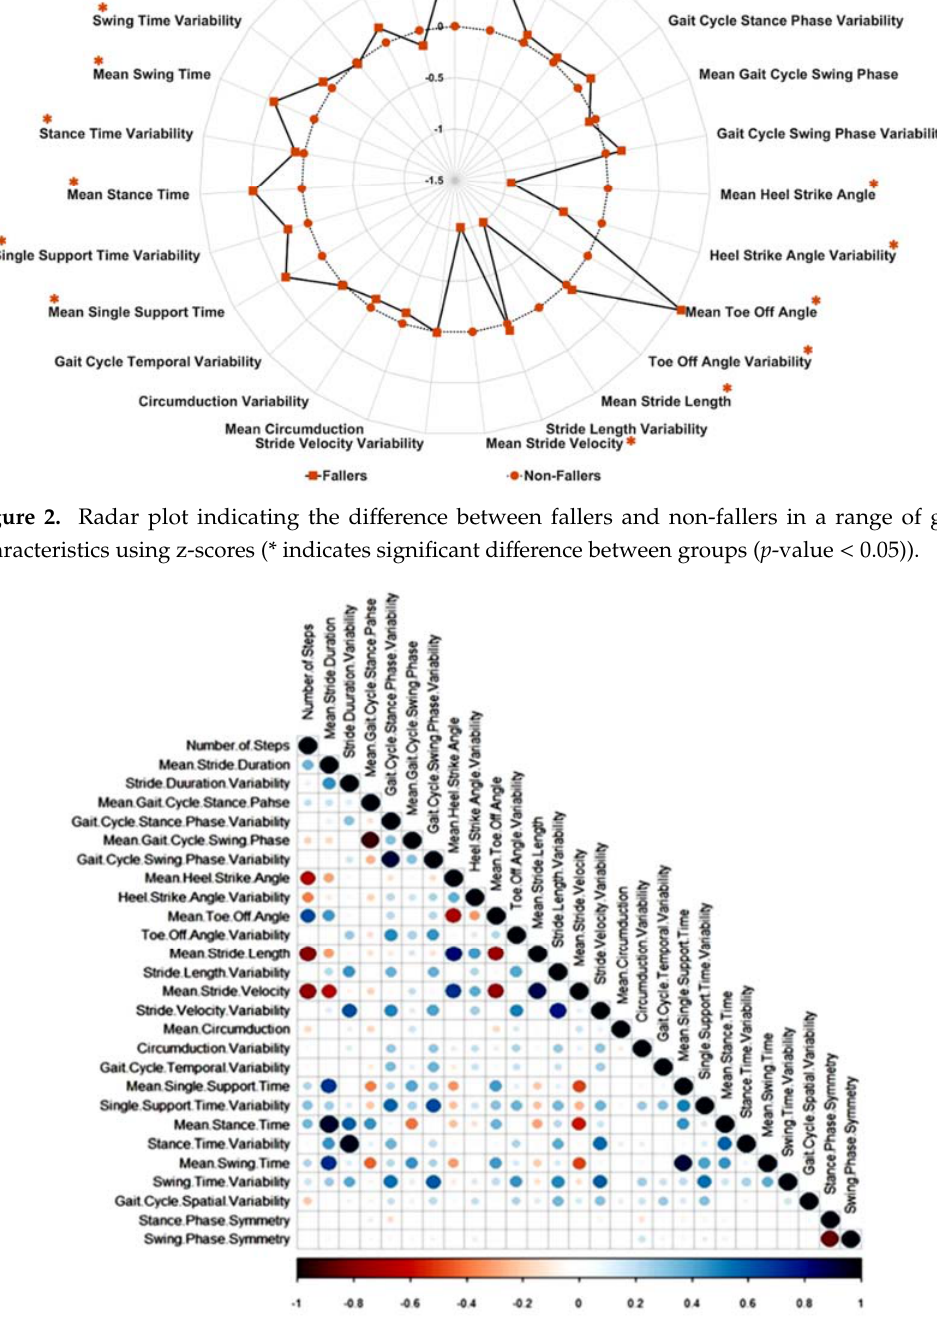
Figure 3. Correlation among the gait characteristics; the bigger the circler, the higher the correlation. Blue means positive correlations and red means negative correlations.